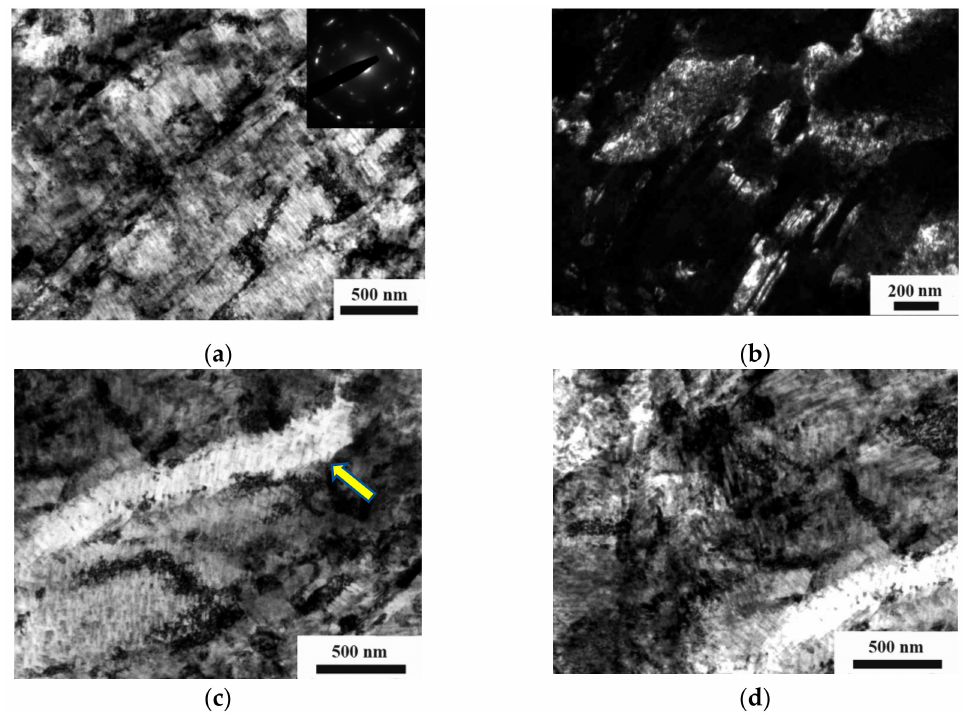
Figure 4. TEM observations of the fine microstructure of the TWIP steel subjected to ECAP for 11 passes. Bright-field ( a ) and dark-field ( b ) images showing the transformation of deformation bands into elongated subgrain structures and a corresponding diffraction pattern ( a ). Areas with truncated deformation bands annotated by an arrow ( c ) and newly formed more equiaxed fragments containing high densities of nanotwins are also shown ( d ). The selected area electron diffraction pattern in ( a ) was taken from the 1 µ m 2 area corresponding to the middle of the